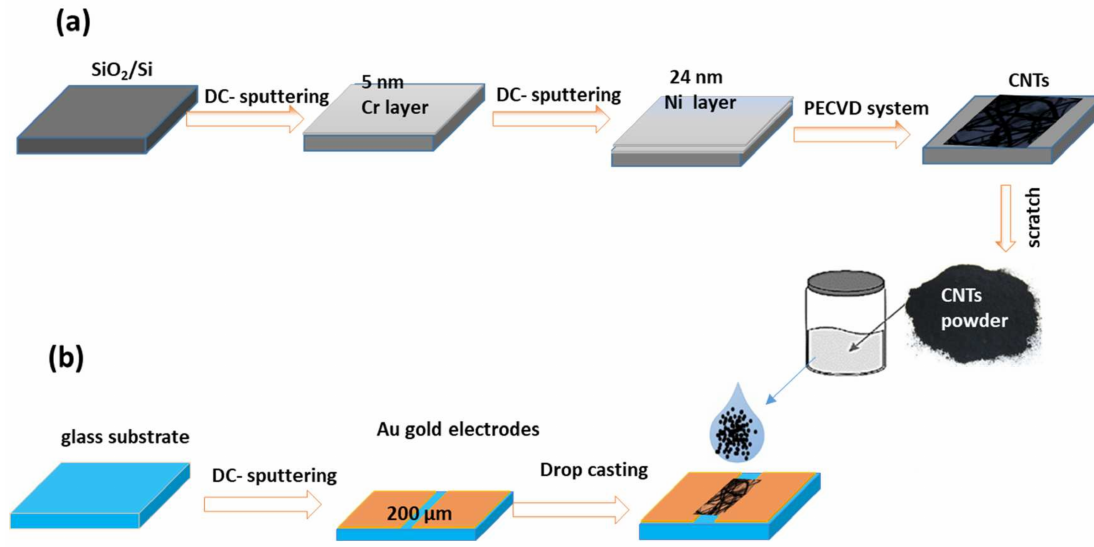
Figure 1. Schematic diagram for; ( a ) CNTs’ synthesis, and ( b ) sensing device